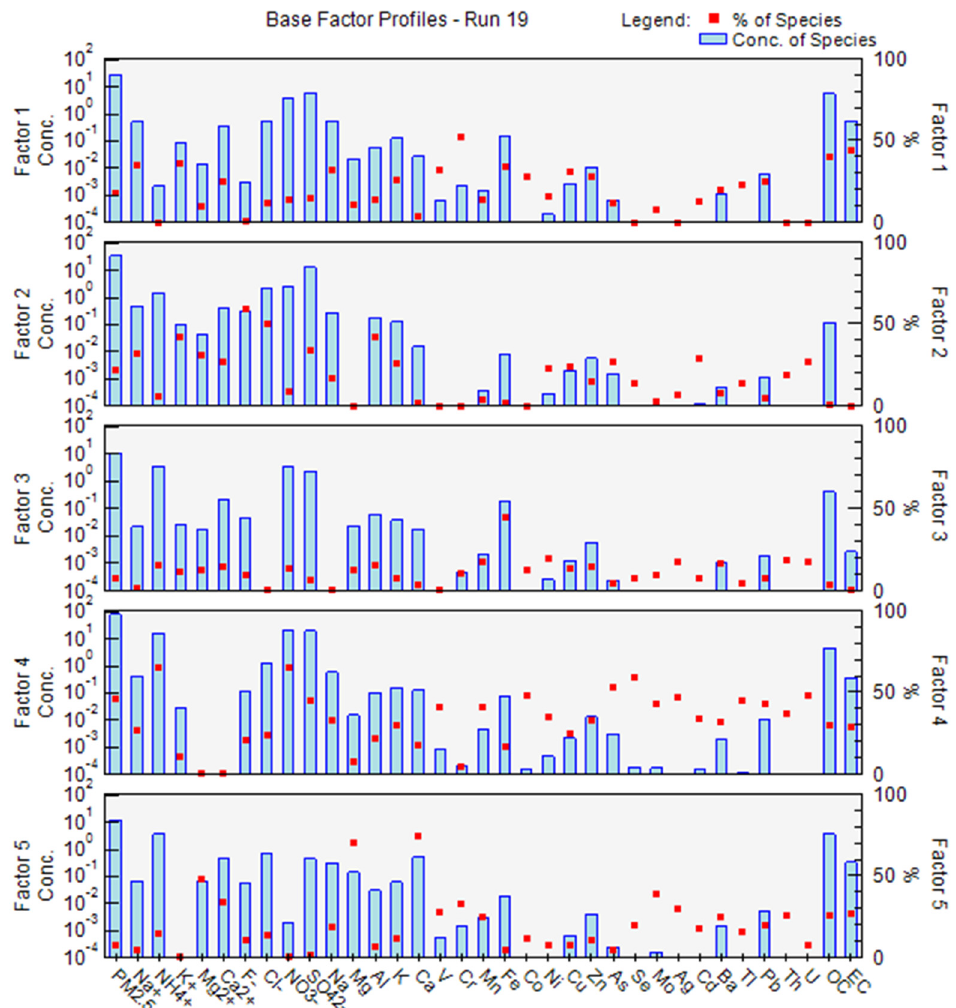
Figure 7. Source profiles of PM 2.5 in Shihezi in winter, based on the PMF model